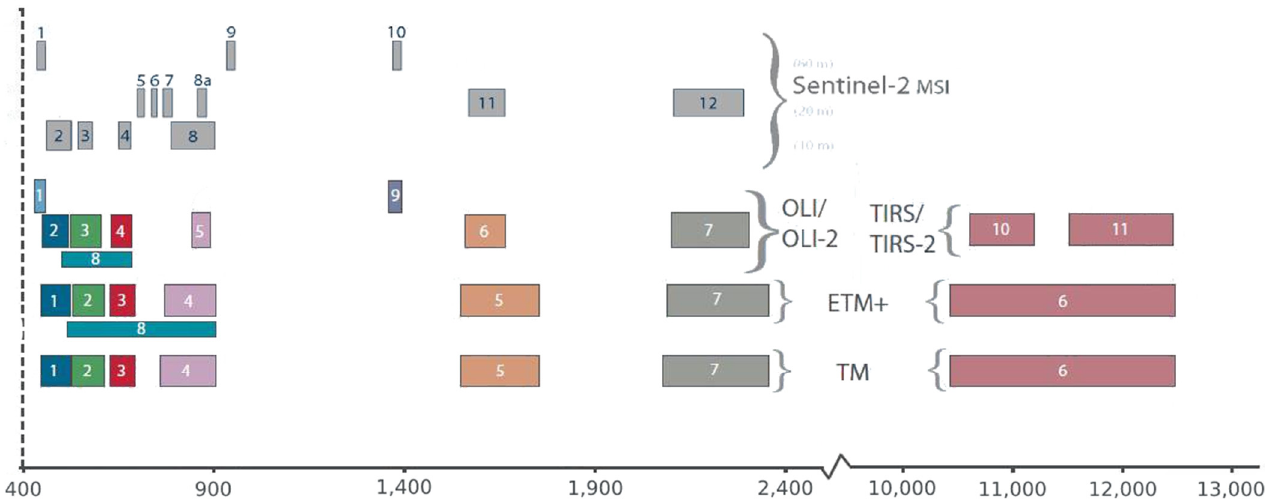
Figure 1. Comparison and location of spectral bands of Landsat-4 TM, Landsat-5 TM, LandSat-7 ETM +, LandSat-8 OLI, LandSat-9 OLI-2 and Sentinel-2 MSI. The numbers indicate the number of spectral bands considered in each sensor. Figure adapted from [20].